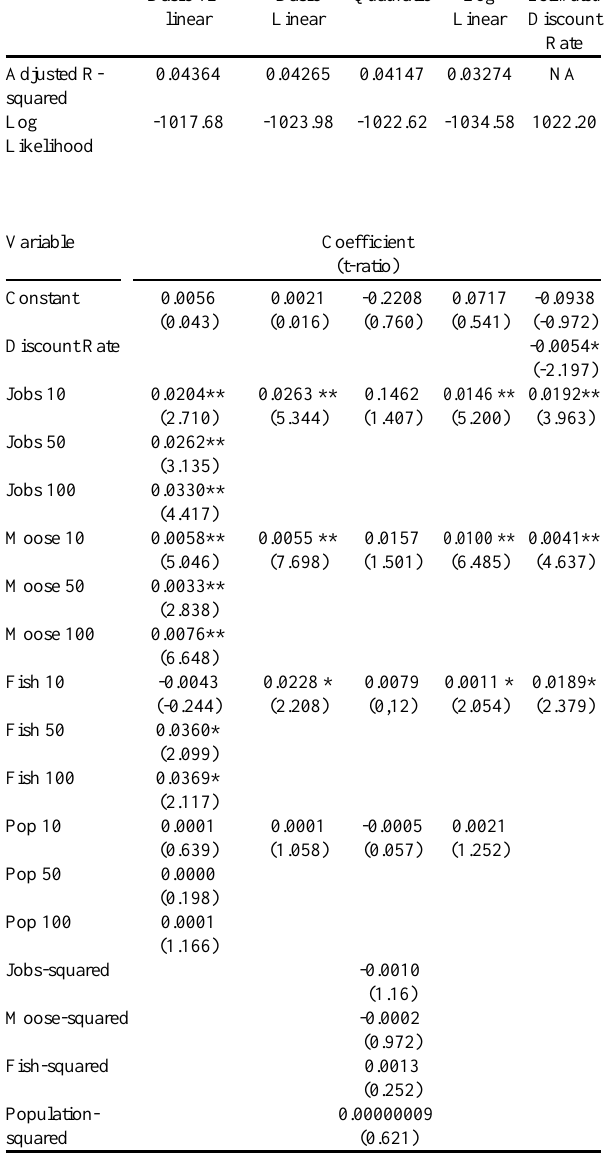
Table 3 . Results from the regression models Basic 12 -